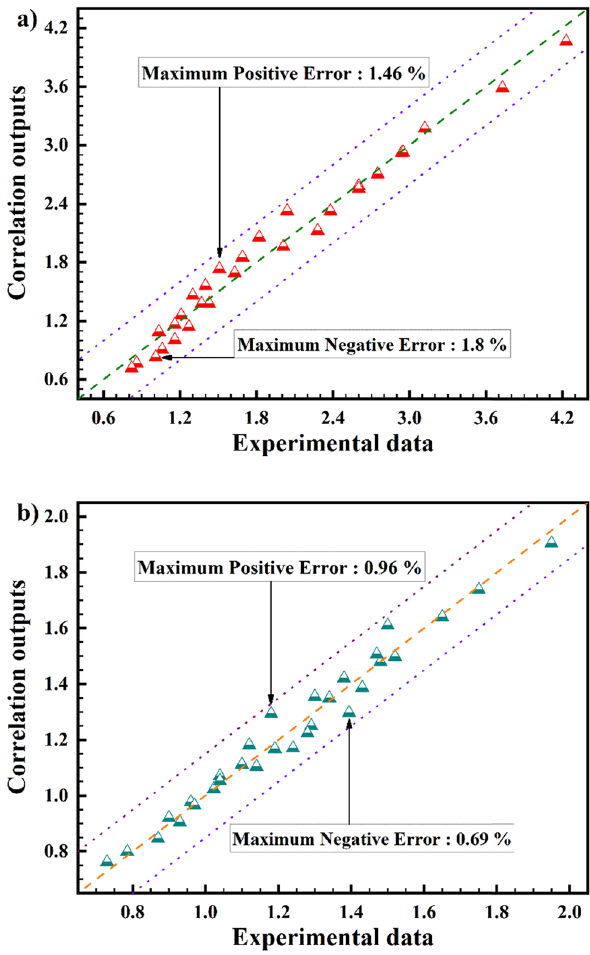
Figure 17: A ffi rmation of original correlation with from factual data for ( a ) 10 RPM and ( b ) 100